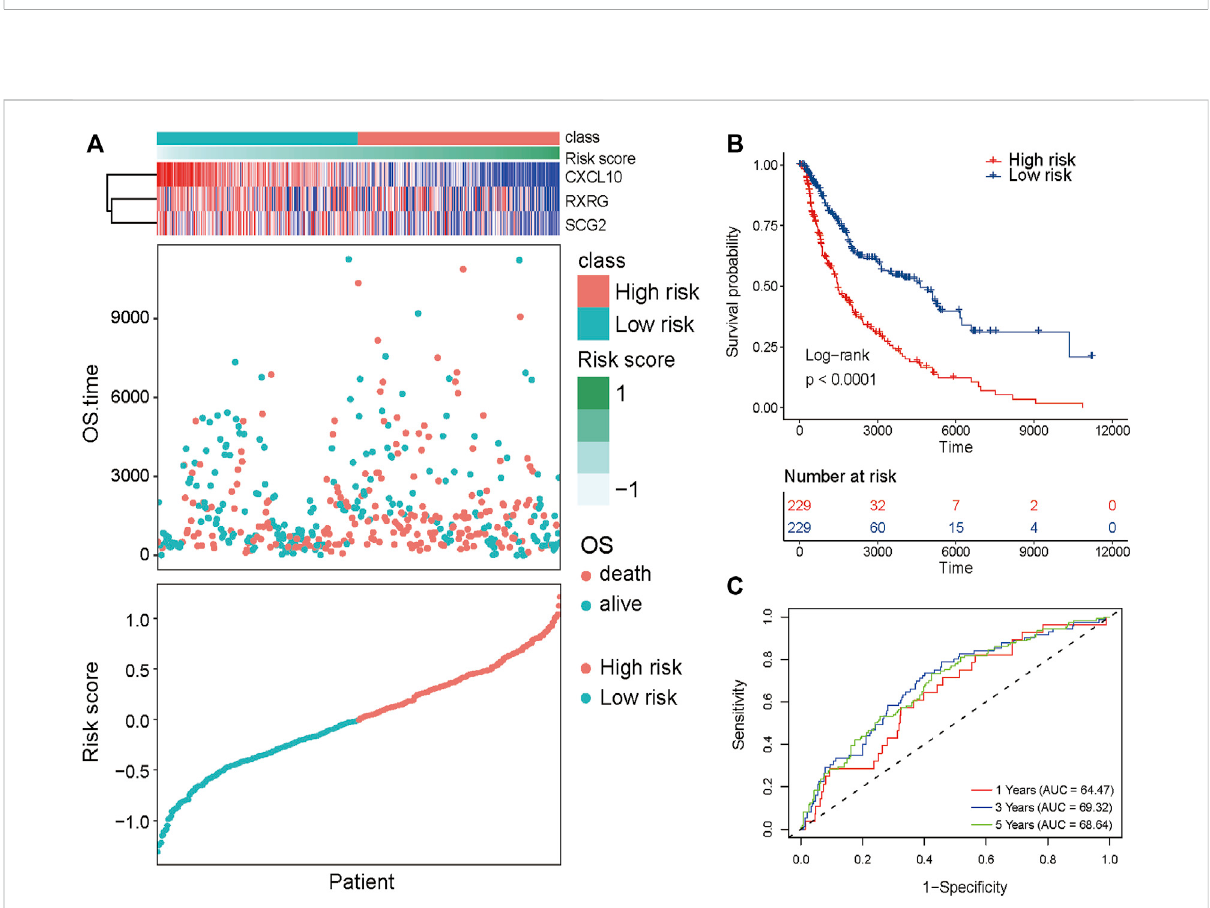
FIGURE 6 Prognostic value of the proposed subtyping for SK CM. (A) Risk Score, and expression of 3-gene in TCGA training set. (B) KM survival curve distribution of 8-gene signature in training set. (C) ROC curve of 3-gene signature classi fi cation and